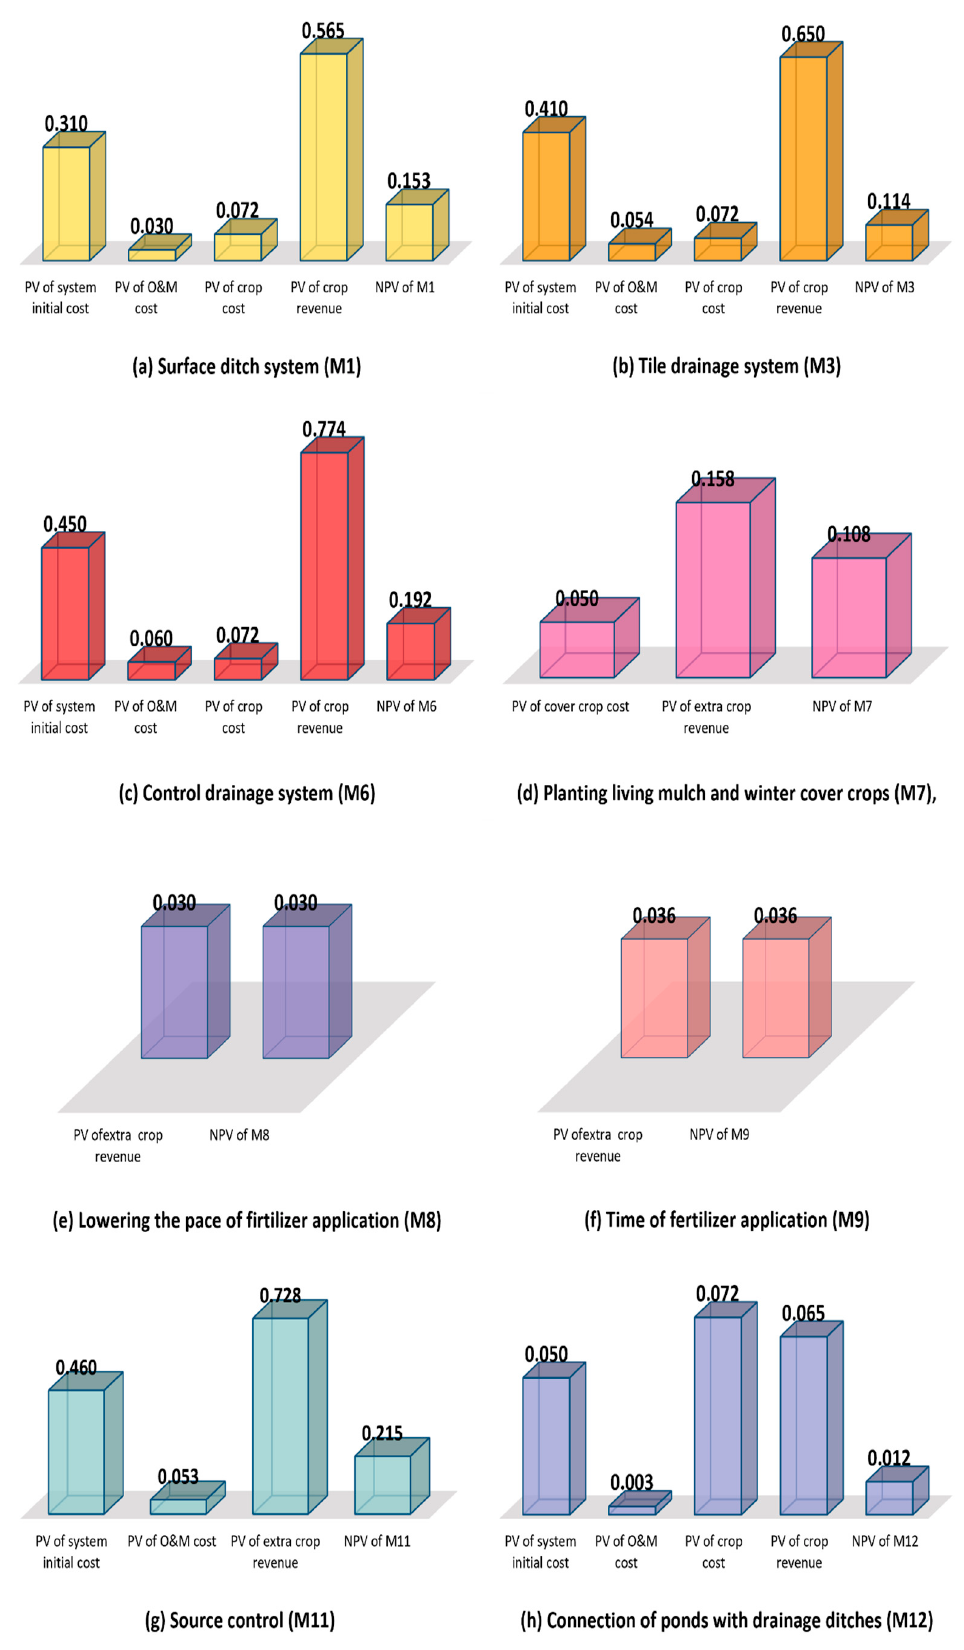
Figure 4. Costs, benefits, and NPV ($/m 2 ) for M 1 , M 3 , M 6 , M 7 , M 8 , M 9 , M 11 , and M 12 .